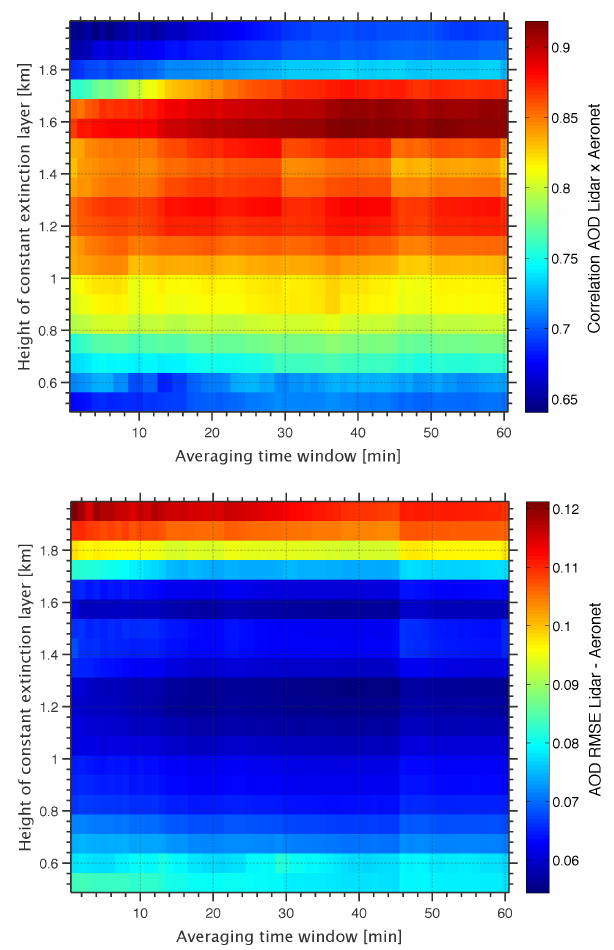
Figure 15. Time correlation (top) and root mean square error (RMSE, bottom) between AERONET AOD and elastic lidar AOD time series are shown as a function of the averaging time window and the height of the constant extinction